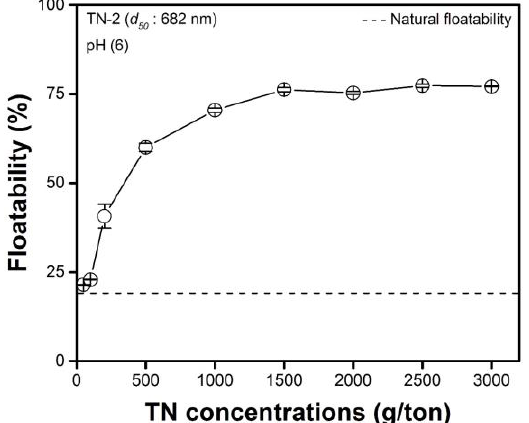
Figure 8. Malachite floatability as a function of TN concentrations. The flotation tests were performed at pH 6 using TN-2.